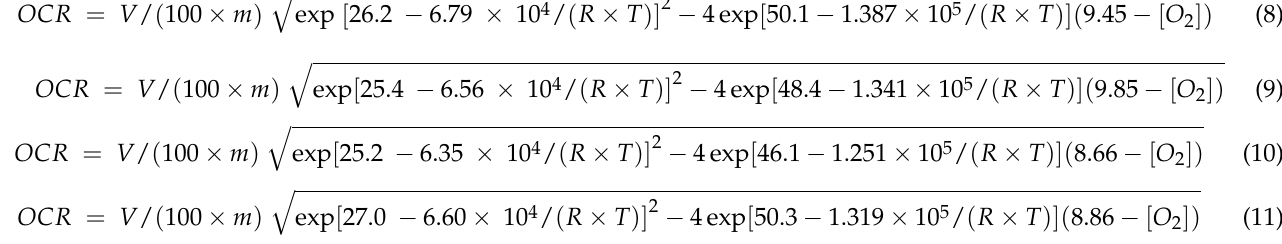
Table S1: Coefficients for the quadratic function describing the evolution of the O 2 concentration in function of